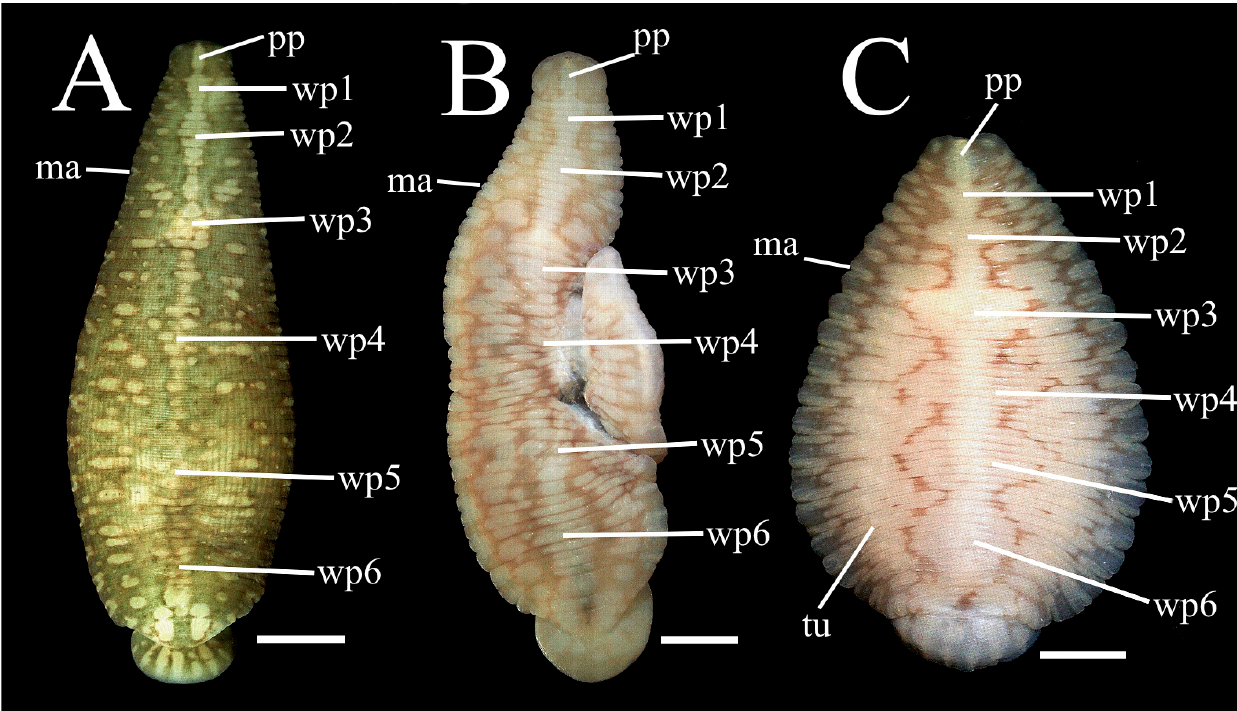
Figure 2. The dorsal pigment pattern of P. parasitica is the most useful character for identifying this species. The pattern is most complex in the adult but is developmentally derivable from a simpler pattern which is ultimately reminiscent of that found also in the P. rugosa clade. Shown are three fixed individuals of decreasing size from the same locality in Outer Banks. ( A ) PP-4a, 39.8 mm. ( B ) PP-2, 22.0 mm. This individual was bitten by its turtle host Kinosternon subrubrum shortly after capture. ( C ) PP-3, 12.8 mm. Note the changes with maturation in the six mid-dorsal white patches (for earlier stages see Figures 10–12). Abbreviations: ma, metameric marginal pattern; pp, placobdellid head pattern; tu, tubercle (diminutive); wp1–wp6, white patch 1 to white patch 6. Scale bars: ( A ) 5.0 mm; ( B ) 2.5 mm; ( C ) 2.0 mm.